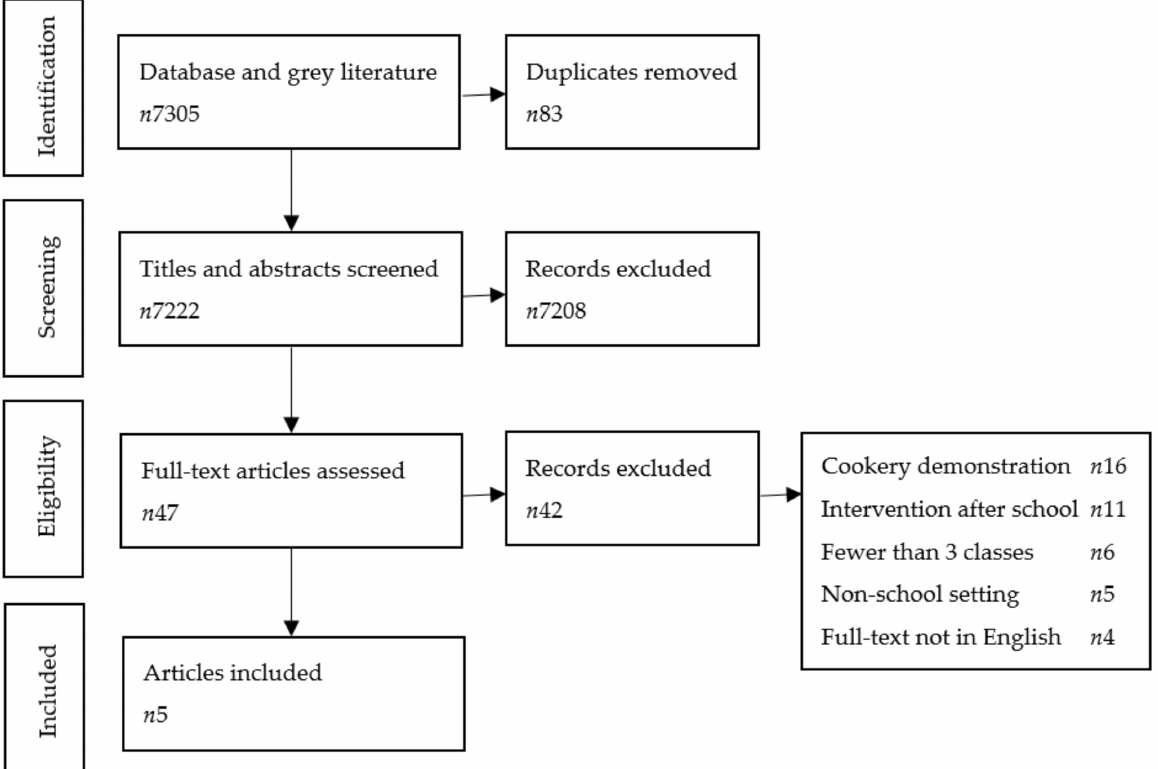
Figure 1. Flow chart depicting each stage of study